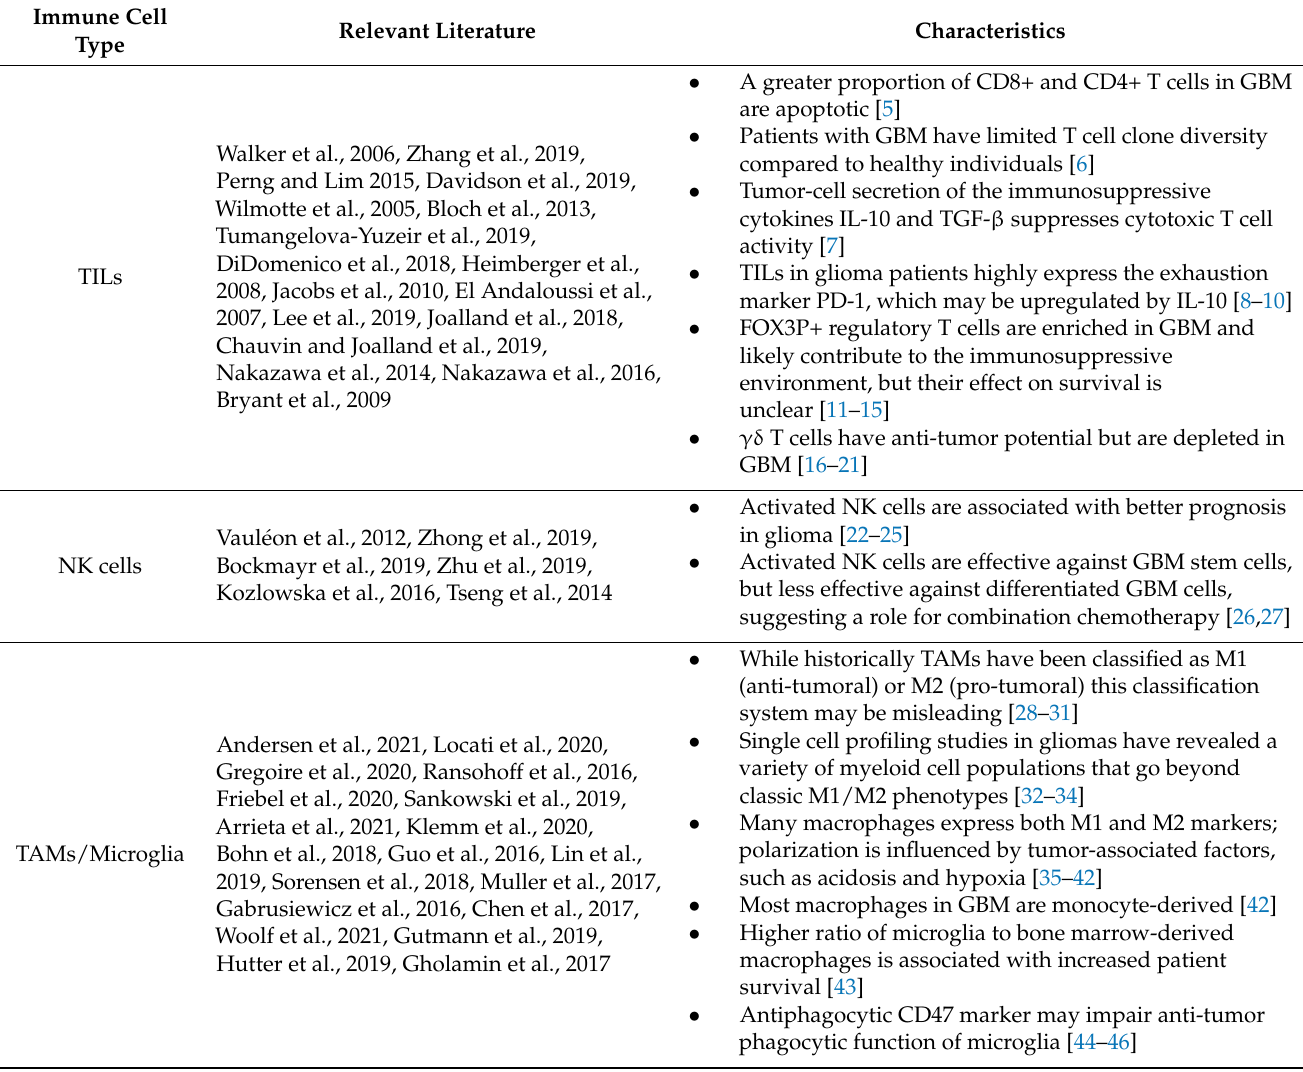
Table 1. Summary of immune cell infiltration of